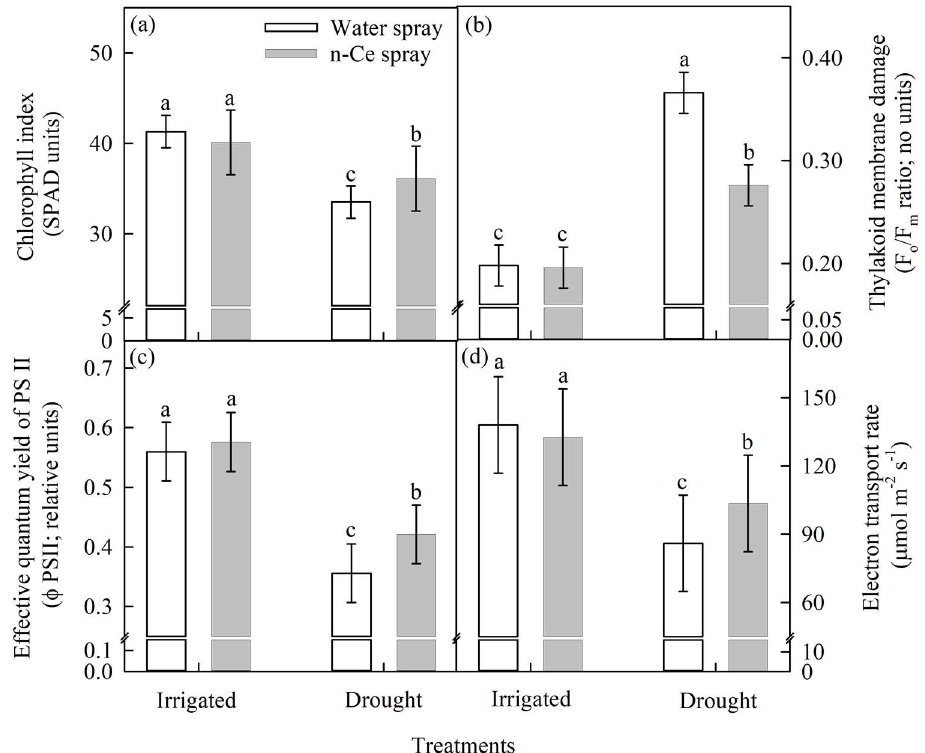
Figure 5. Effect of drought and foliar spray of nanoceria on ( a ) chlorophyll index (SPAD units), ( b ) thylakoid membrane damage (Fo/Fm ratio), ( c ) effective quantum yield of PSII ( φ PSII; relative units), and ( d ) electron transport rate (µmol m −2 s −1 ) in mungbean (pot culture experiment). The values of chlorophyll index and Fo/Fm ratio are mean ± SD of 15 independent measurements (5 replicates × 3 observation times), and PSII and ETR are mean ± SD of 9 independent measurements (3 replicates × 3 observation times). Means with different letters are significantly different at p ≤ 0.05.